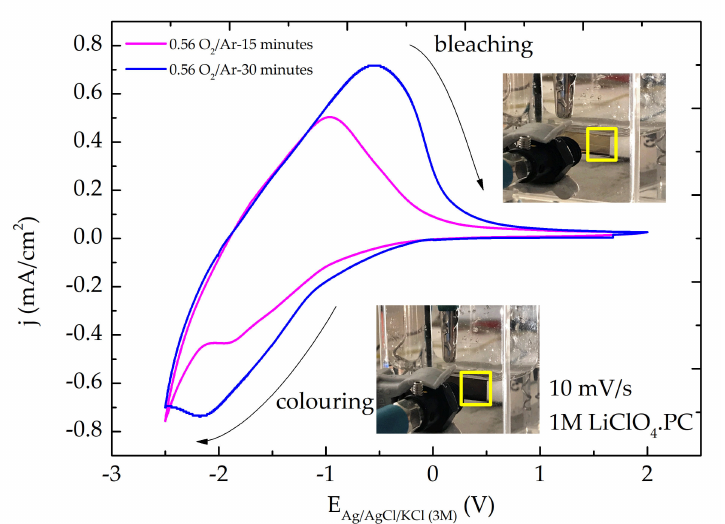
Figure 11. Comparison of typical CV curves of MoO x thin films grown on PET-ITO substrate with different deposition times at a scan rate of 10 mV/s. The arrows indicate the scan direction.